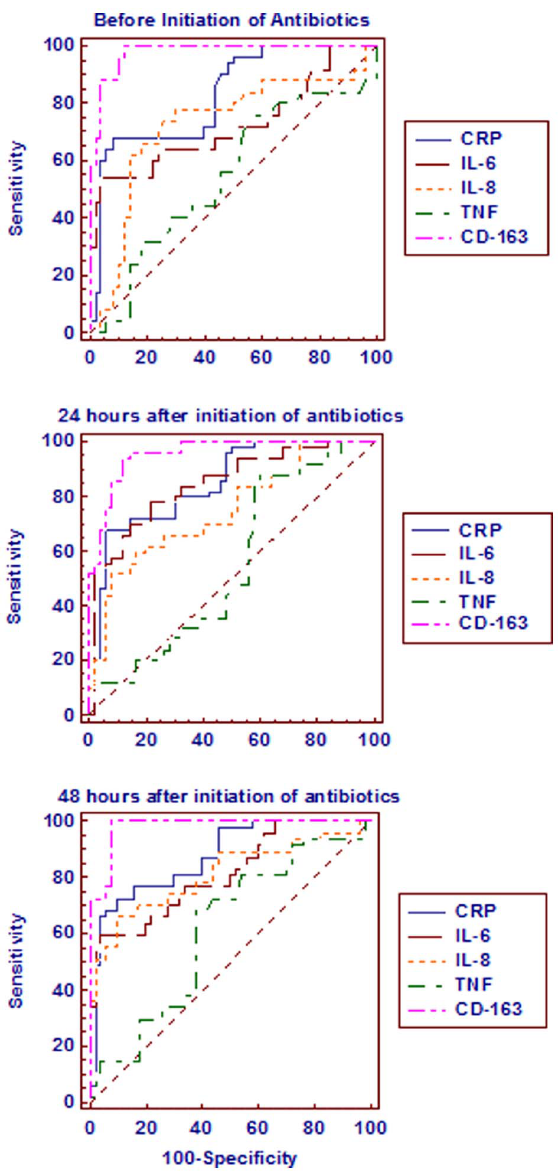
Figure 1. Comparison of the receiver operative curves of all the study parameters between the non-infected and infected neonates at different time intervals. doi:10.1371/journal.pone.0068426.g001 1.013, P= 0.002) (Table 7). The most powerful indicator for the